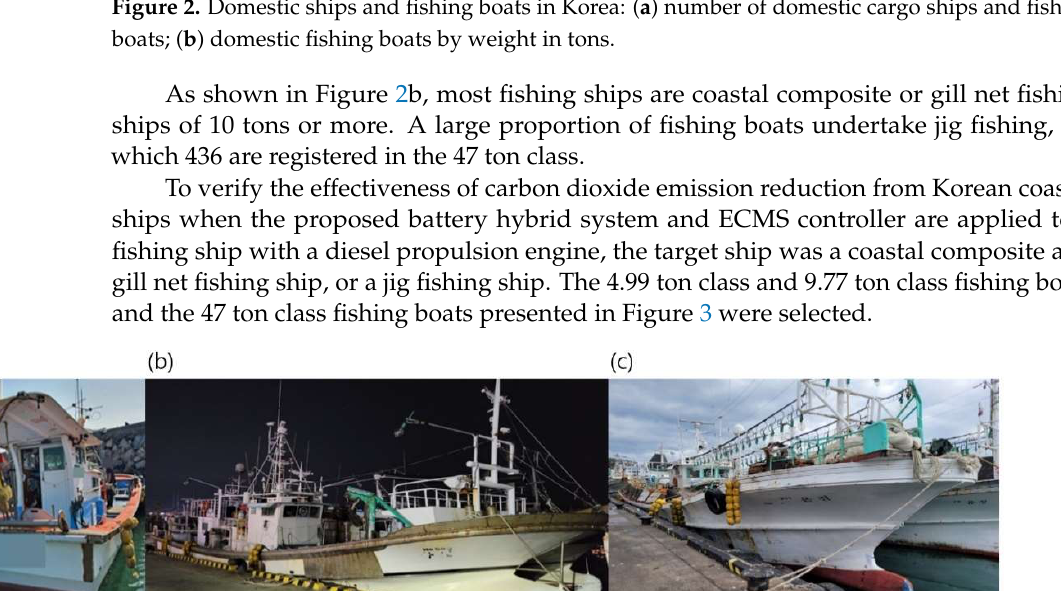
Figure 2. Domestic ships and fishing boats in Korea: ( a ) number of domestic cargo ships and fishing boats; ( b ) domestic fishing boats by weight in tons.